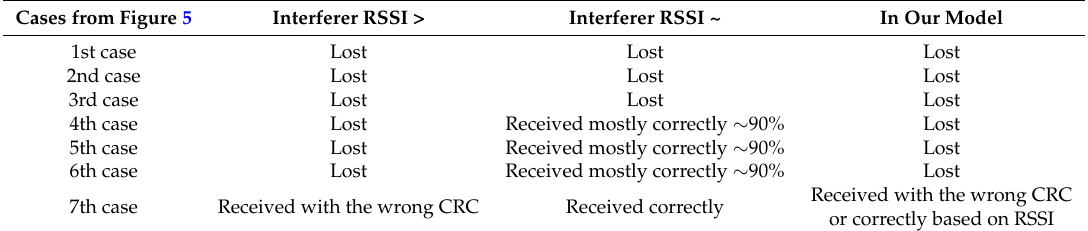
Figure 5. All of the possible cases that an interfered transmission can collide with the interferer. Table 6. Status of the packet from the interfered transmission for different cases from Figure 5. Cases from Figure